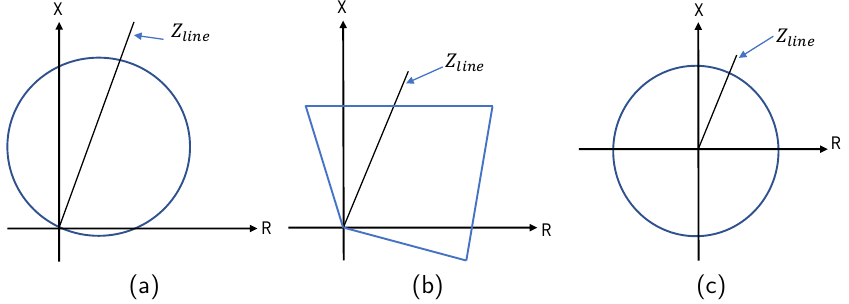
Figure 3. Distance relay characteristics on R – X diagram: ( a ) mho; ( b ) quadrilateral; ( c )